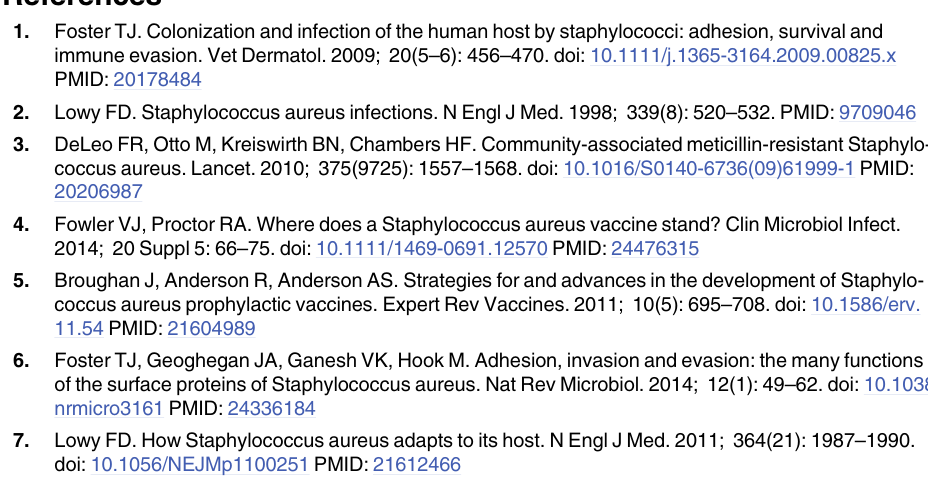
S1 Fig. MAP27 immunization decreases the bacterial burden in organs. Mice were immu- nized with MAP27 or MAPctrl for five times at a two-week interval without bacterial boost (A, C), or with bacterial boost (B, D). All the mice were infected with S . aureus via tail vein post five days of the last immunization. The bacterial numbers in organs were measured after three days of infection. Bacterial burden in kidney (A, B) and in lung (C, D) were